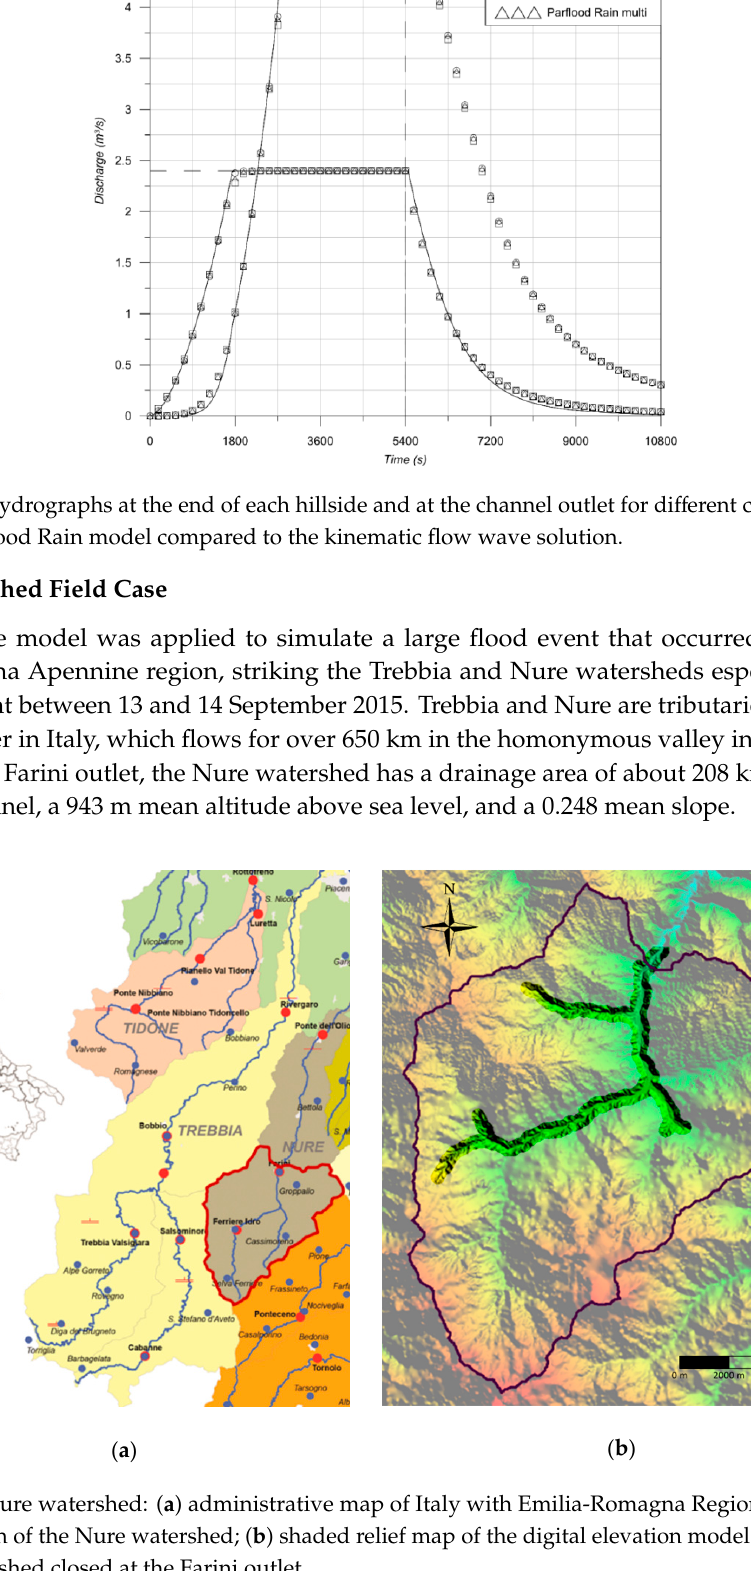
the Nure watershed closed at the Farini outlet. Nure watershed closed at the Farini